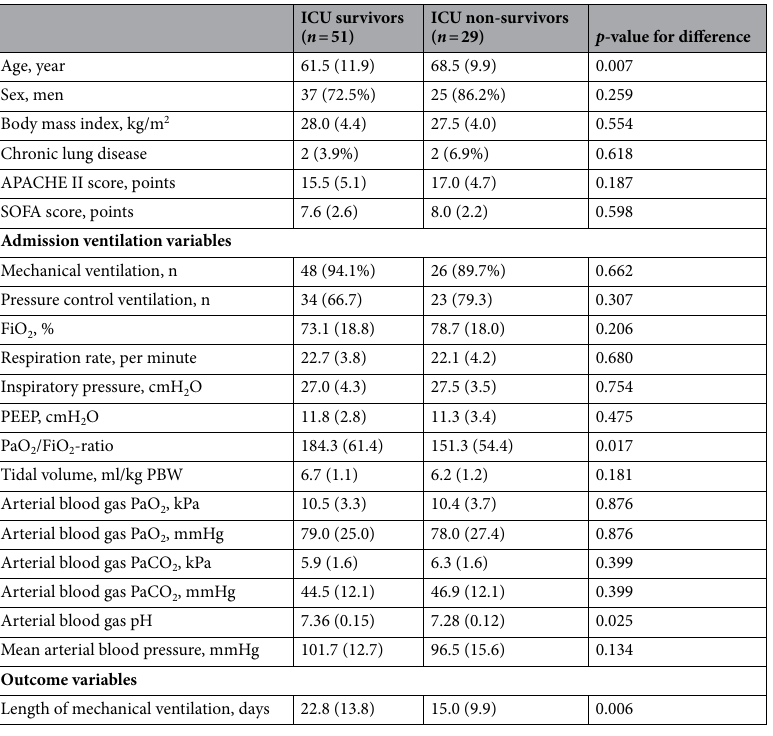
Table 1. Baseline demographic and clinical characteristics of the study population. Data are means SD, median (IQR), and percentages as appropriate. ICU, Intensive Care Unit; APACHE II, Acute Physiology And Chronic Health Evaluation II; SOFA, serial organ failure assessment; FiO 2 , fraction of inspired oxygen; PEEP positive end-expiratory pressure; PBW, predicted body weight; PaO 2 /FiO 2 -ratio, oxygen arterial partial pressure on inspired fraction of oxygen ratio; PaO 2 , oxygen arterial partial pressure; PaCO 2 , carbon dioxide arterial partial